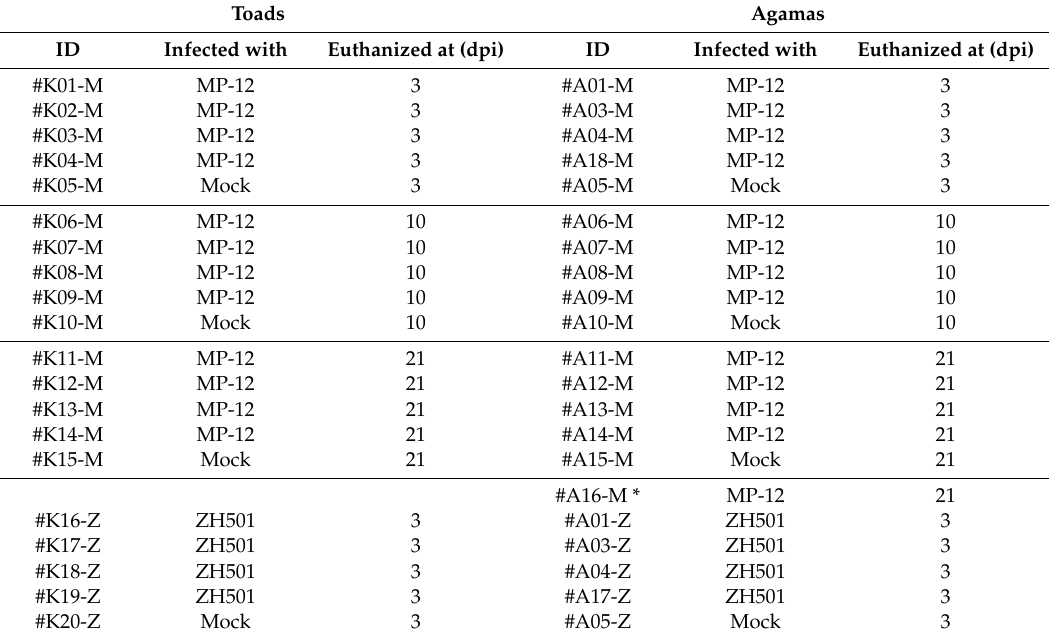
Figure 1. Husbandry of animals. ( A ) Husbandry of toads, ( B ) husbandry of agamas, ( C ) individual identification of toads, ( D ) individual identification of agamas. Table 1. Individual animal identification and